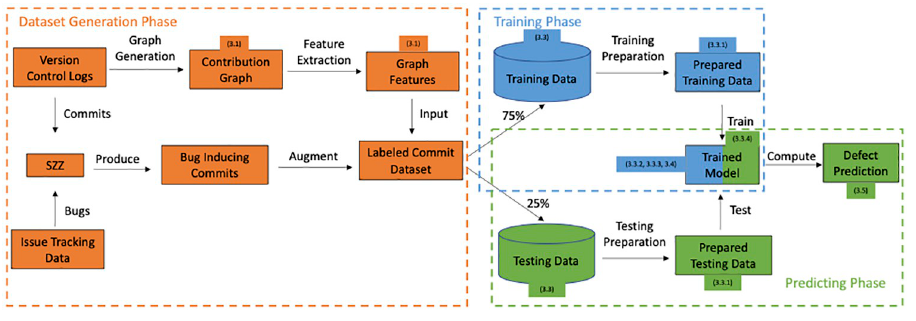
Fig 1. Graph-based ML JIT defect prediction